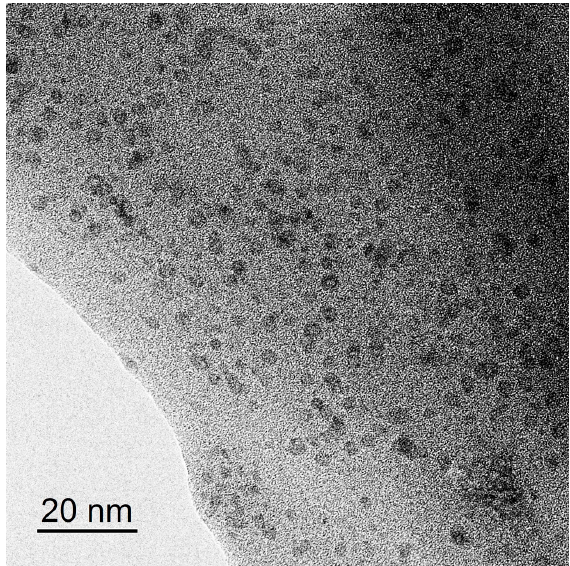
Figure 3. TEM image of the NC3-0.2S hybrid membrane.